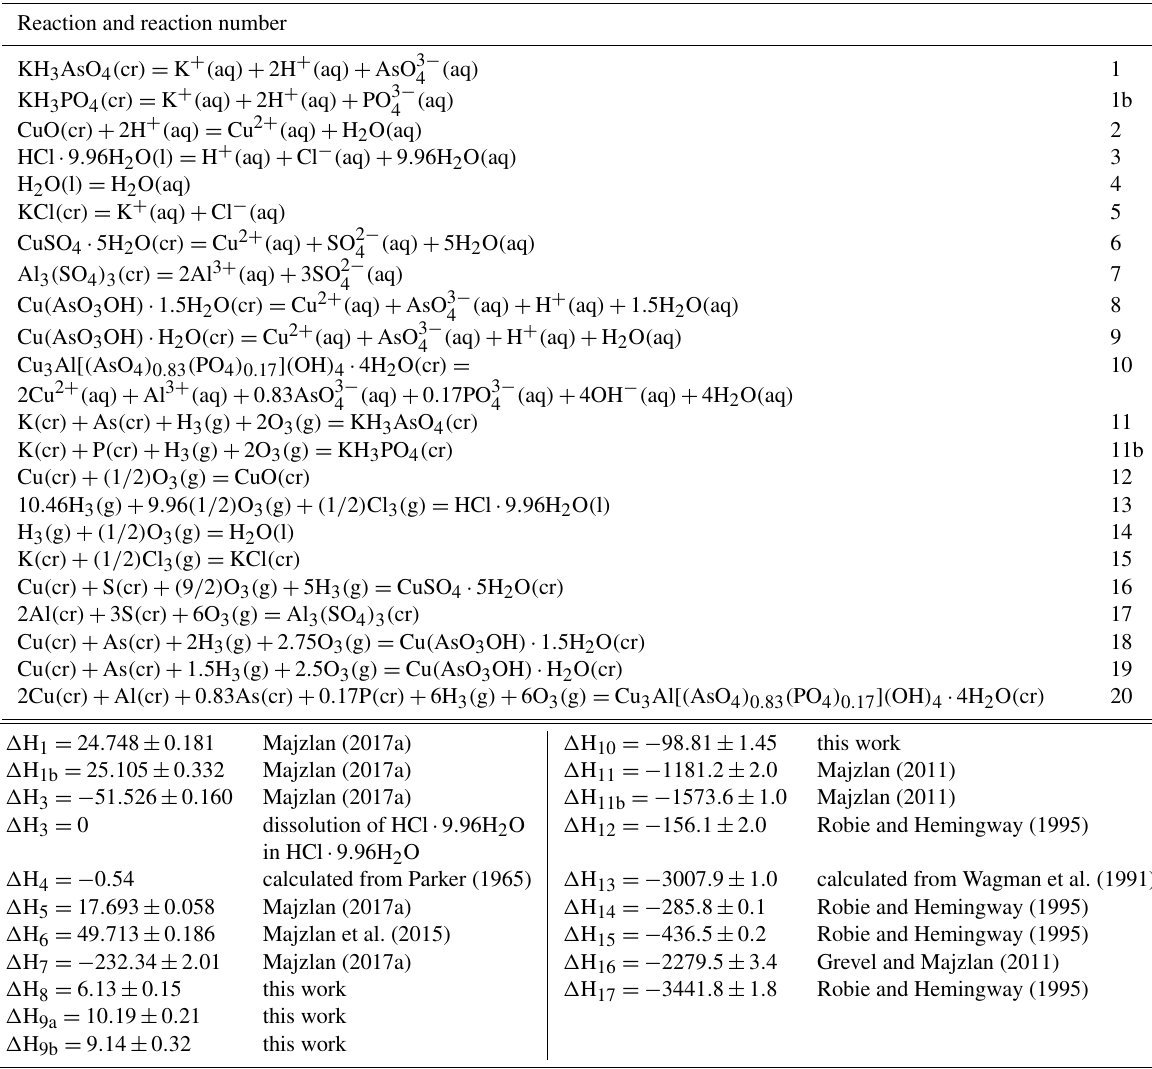
Table 8. Thermochemical cycle for the studied minerals. Reaction and reaction